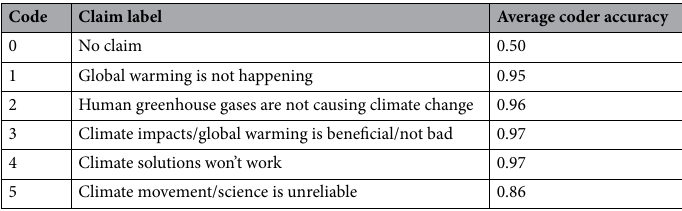
Table 1. Average annotator performance by